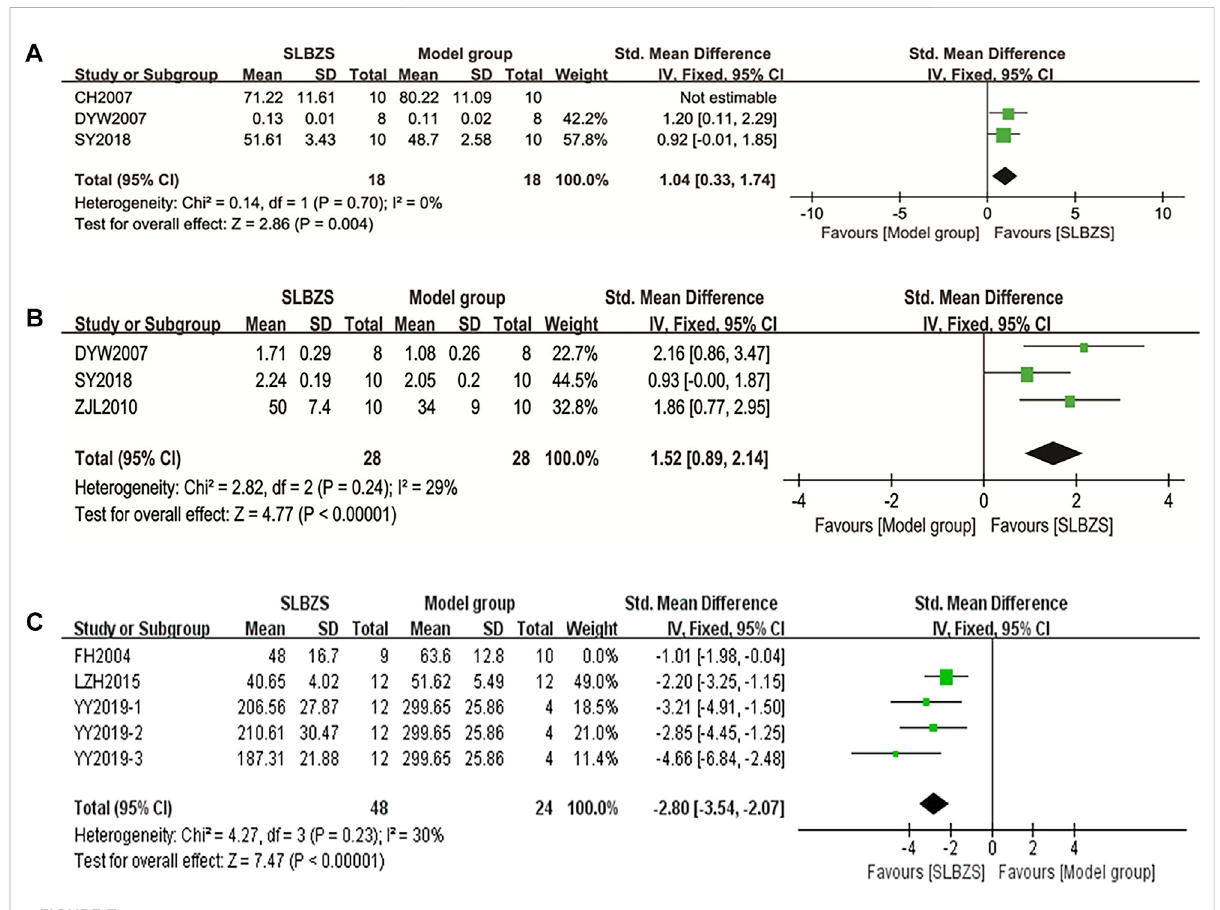
FIGURE 7 (A) The results of sIgA. (B) The results of IL-2. (C) The results of